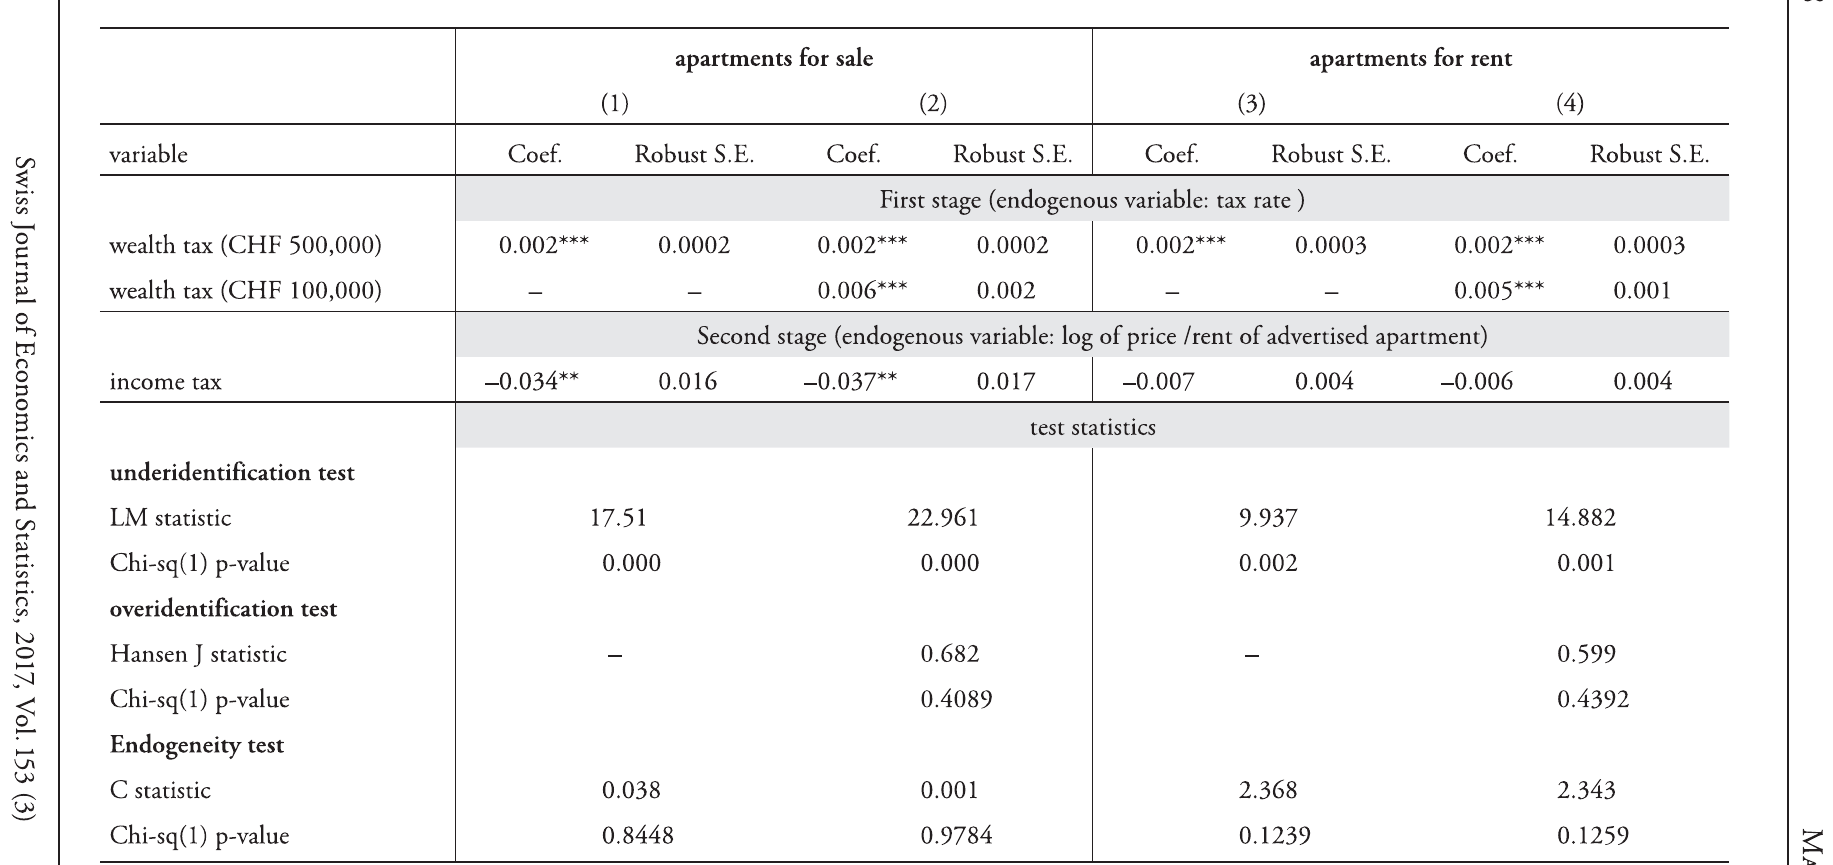
Table 3: Estimation Results